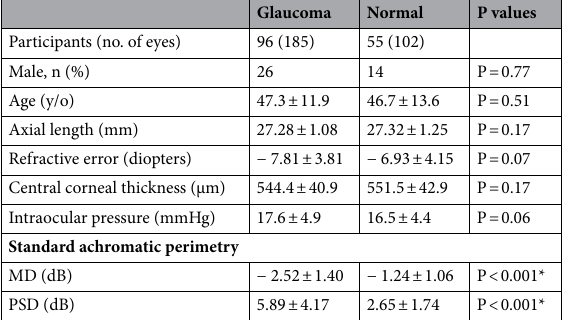
Table 1. Demographics and ocular characteristics of the study population. Data are presented as mean ± standard deviation. MD mean deviation, PSD pattern standard deviation. *Statistical significance shown at p < 0.05.